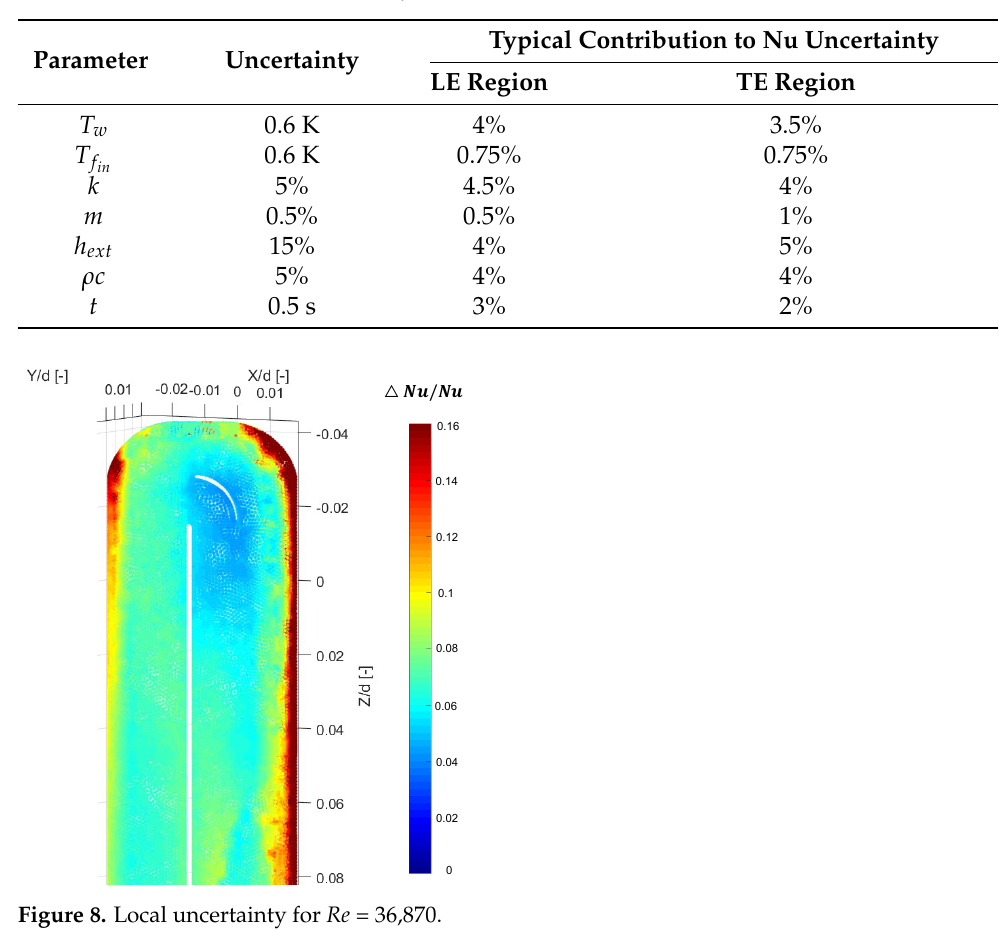
Figure 7. Comparison of the regression results with baseline and correlation for selected LE ch rectangular region. Table 1. Contribution to the uncertainty on Nu .